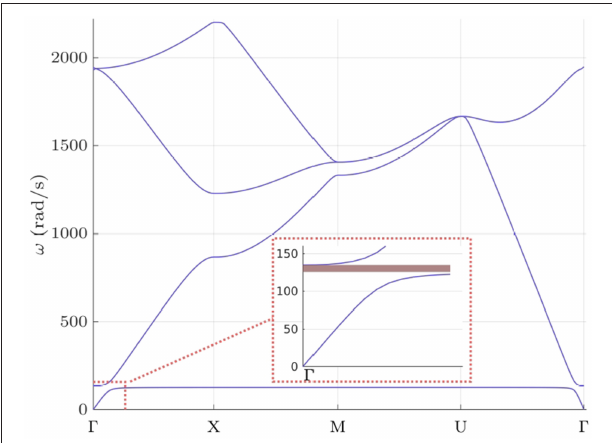
FIGURE 7 | Dispersion diagram for a periodic array (pitch d spherical rigid shells (inner radius R six thin channels (length 0.1 m and radius 0.01m) representing the frequency ω (rad.s − 1 ) of pressure waves in air vs. the wavenumber the Bloch vector k along the edges of the irreducible Brillouin zone Ŵ XMU . We note the appearance of a frequency stop band for ω rad.s − 1 which is wider and at higher frequencies than the stop band in Figure 4 : the more identical thin channels, the higher the resonant frequency of the localized mode.